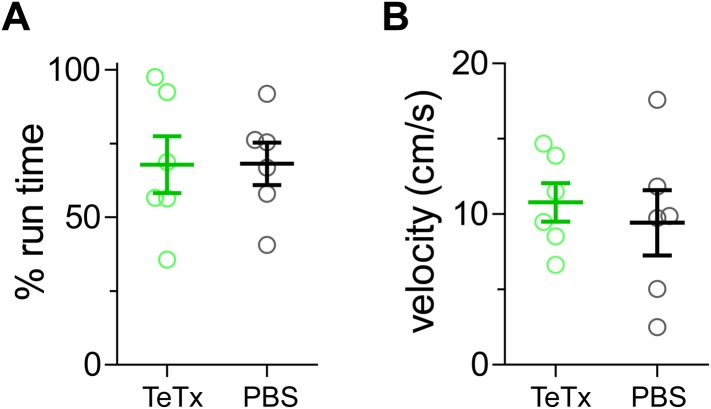
VIP-Cre mice injected with AAV-DIO-TeTx-GFP (TeTx) ran similarly to PBS-injected control mice (PBS).(A) The percentage of running time during the 4-hr visual stimulation on day 14 of recovery from amblyopia. (B) The average running velocity during the running state. Each circle represents one mouse. (Data are plotted as mean ± S.D., p > 0.05 between TeTx and PBS groups).